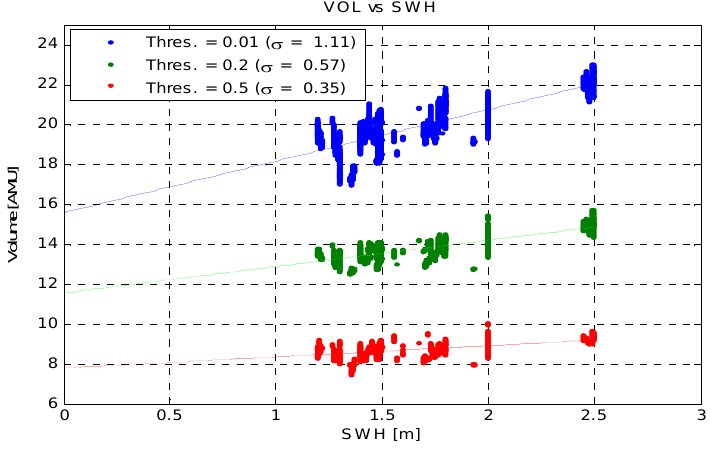
Figure 15. DDM-volume dependence on the SWH for three different thresholds